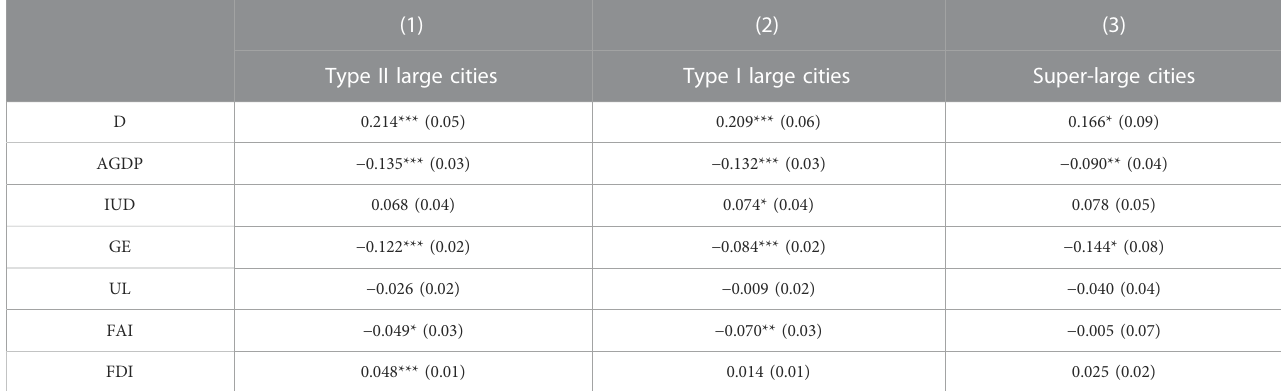
TABLE 9 Population size heterogeneity analysis.